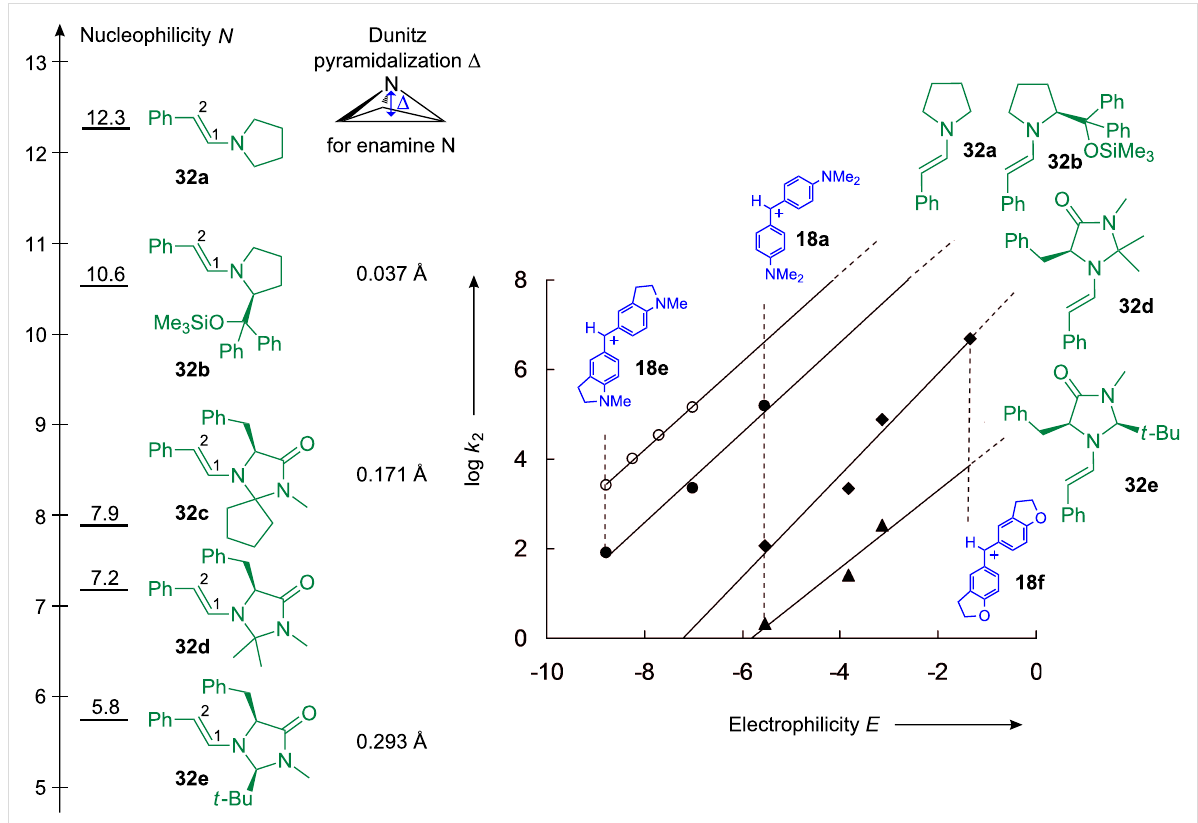
Figure 19: Quantification of the nucleophilic reactivities of the enamines 32a – e in acetonitrile (20 °C) [83]; a definition of the Dunitz pyramidalization Δ is given in [84].